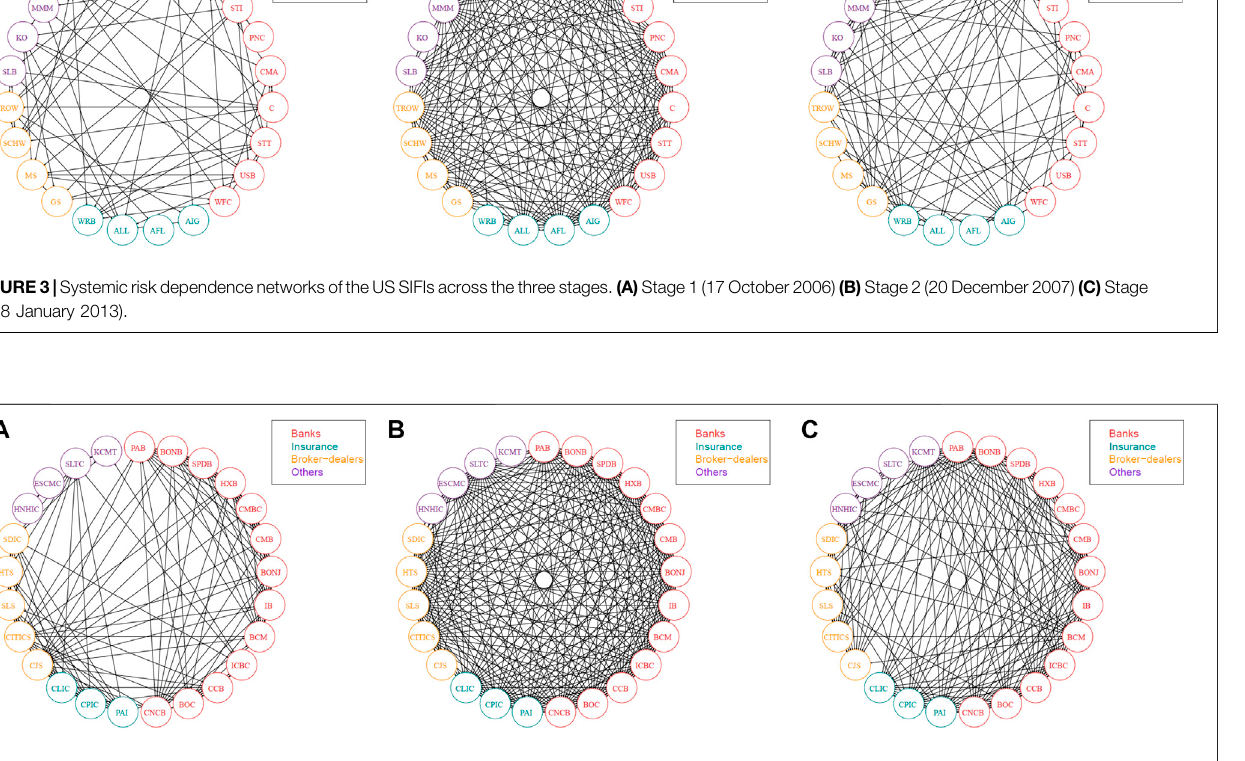
FIGURE4| SystemicriskdependencenetworksoftheChineseSIFIsacrossthethreestages. (A) Stage1(7November2013) (B) Stage2(24April2015) (C) Stage 3 (9 December 2016).